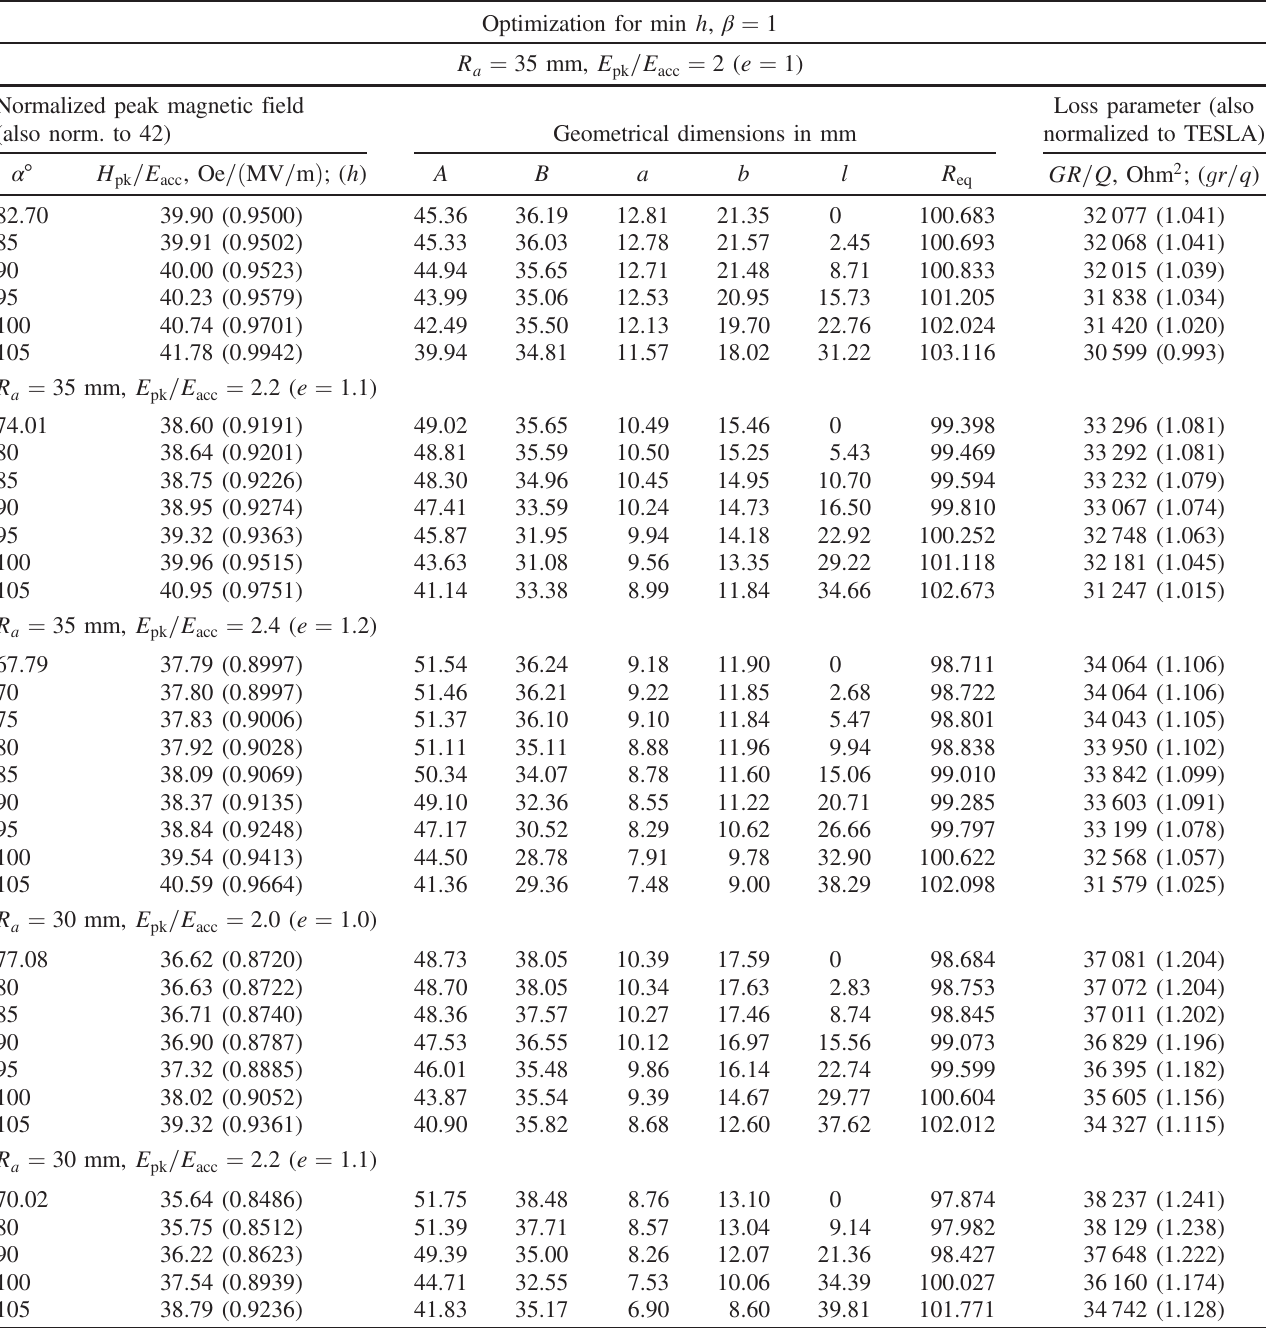
TABLE II. Values of H angle α . Optimization for min H